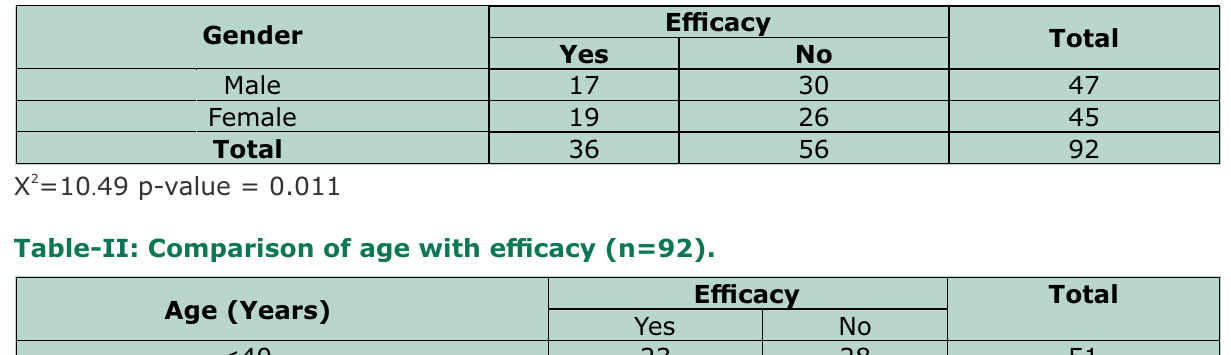
Table-I: Comparison of patients by efficacy (n=92).